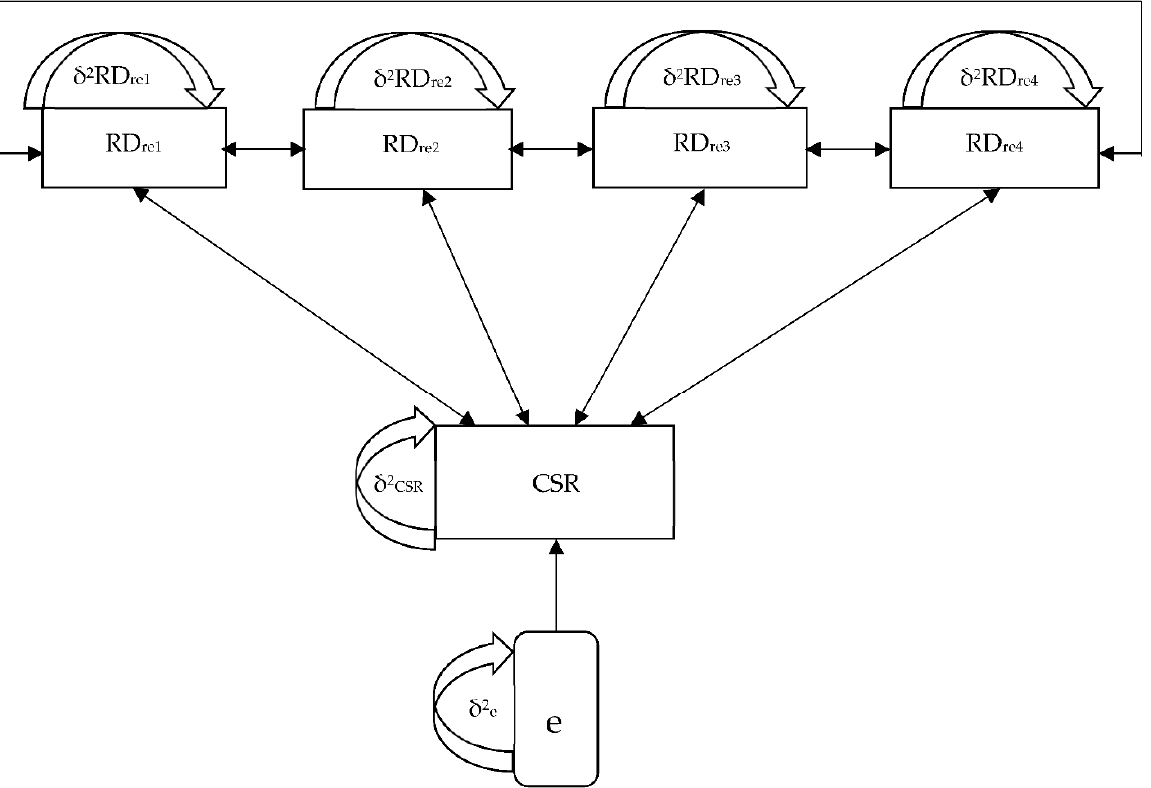
Figure 1. Structural equation model path diagram used in the article. Source: developed and compiled by the authors.